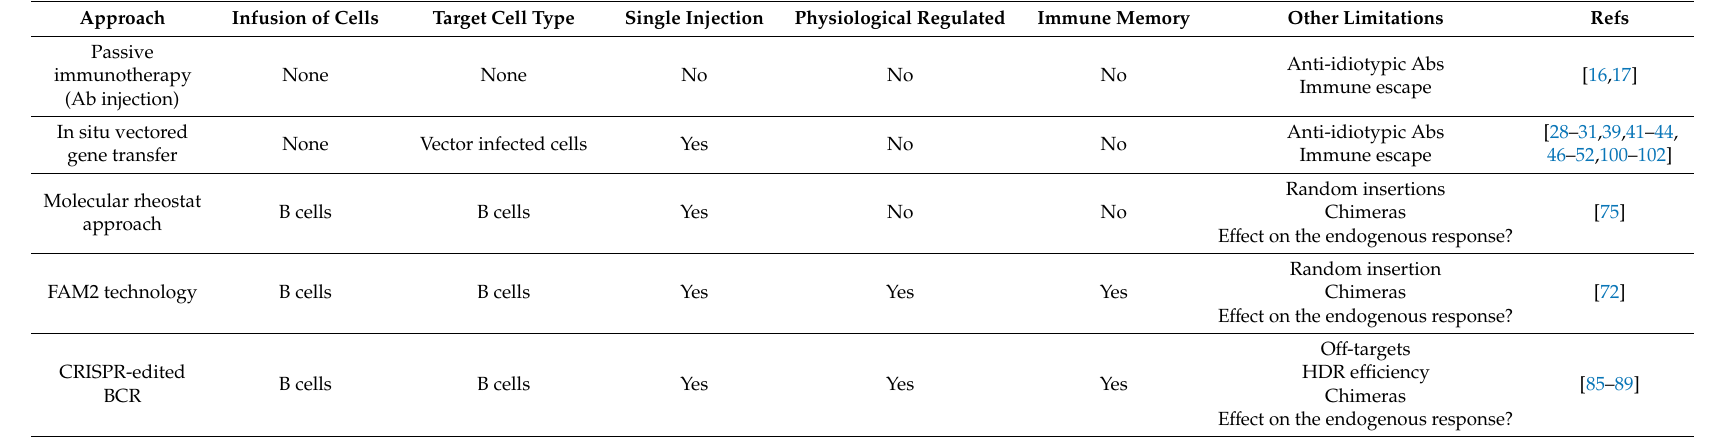
Table 2. Comparison of di ff erent approaches for ectopic antibody